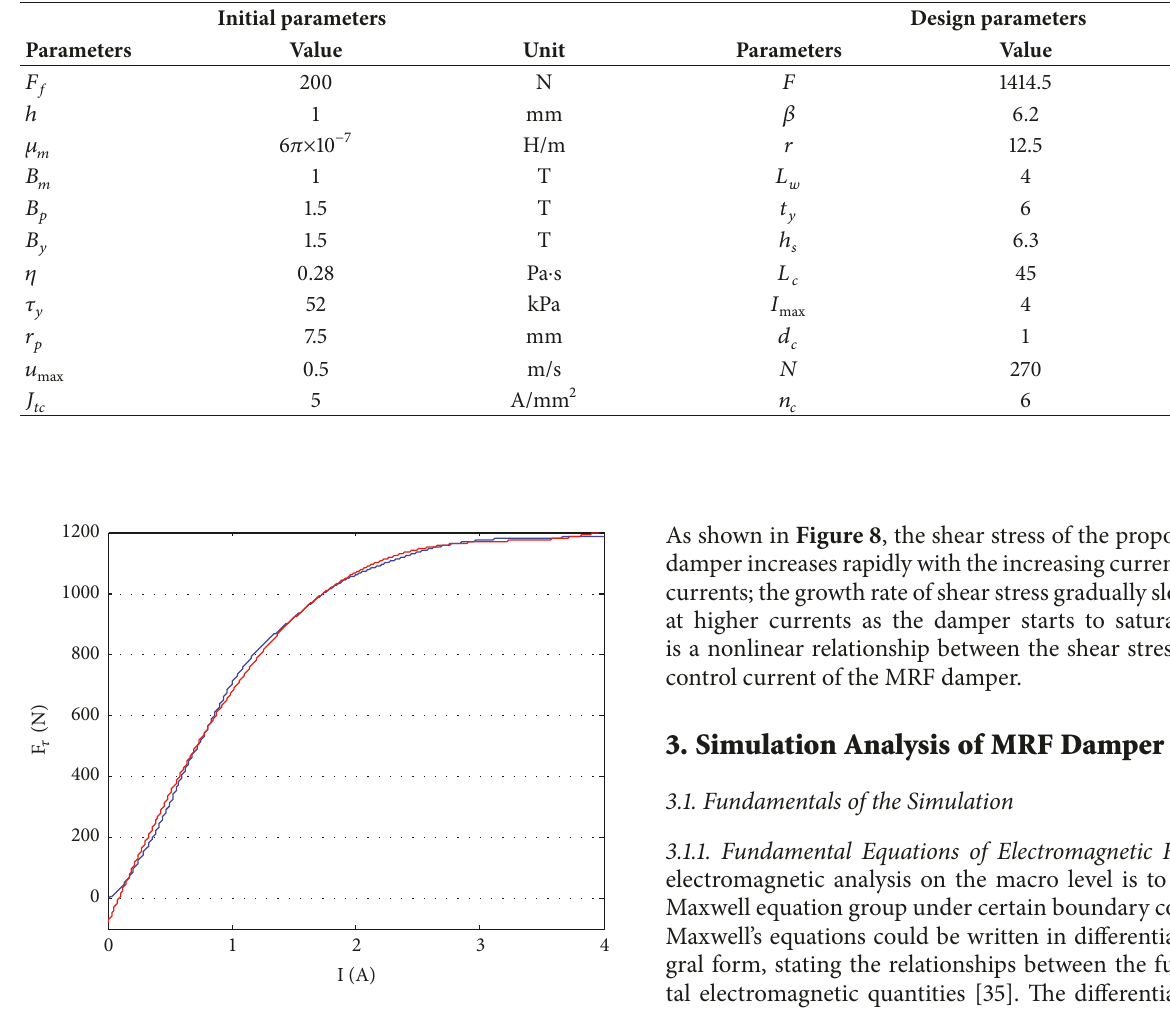
Table 2: Basic structural parameters of MRF damper.